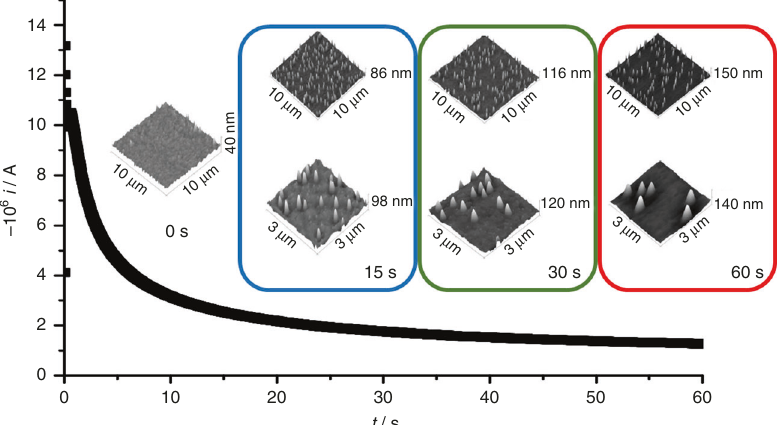
Fig. 2 Current transient recorded at − 0.34 V overpotential on an ITO electrode in 1.0 × 10 − 3 mol dm − 3 CuSO 4(aq) . AFM images recorded ex-situ after 0 (ITO topography), 15, 30 and 60 s are superimposed in the fi gure. Statistical analysis of a number of electrodes resulted in a constant nuclei number density of (1.5 ± 0.8)× 10 8 cm − 2 , which is consistent with an instantaneous nucleation mechanism